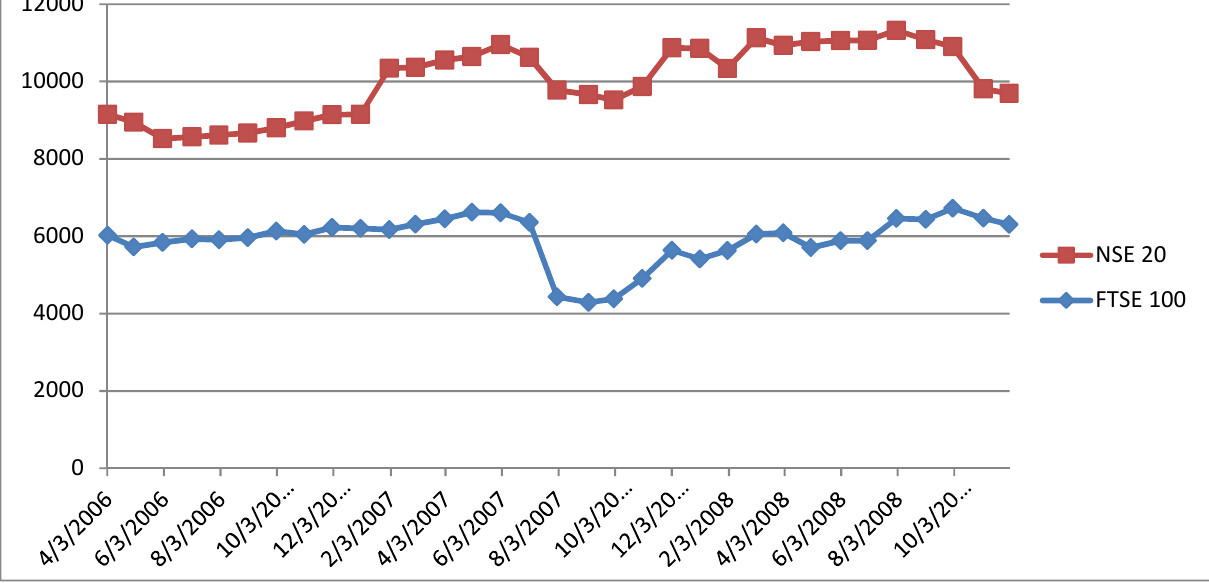
Fig. 6. Pre and post crisis Influence of the performance of NSE 20 Share Index on FTSE